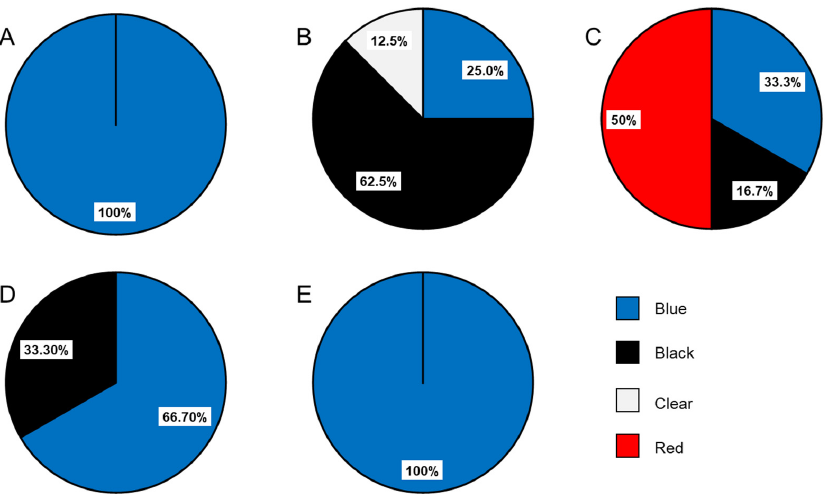
Figure 5. Abundance of microplastic (number of MPs/L) in different water samples: seawater, dis- tilled water + NaCl, purged water every 3 h (PW1, PW2, PW3). Only blue-colored fibers were found in the seawater and in the purged water after 9 h, and blue and black fibers were found in purged water after 6 h, while in the water with NaCl and in the purged water after 3 h, the variability of the colors was greater (Figure 6).